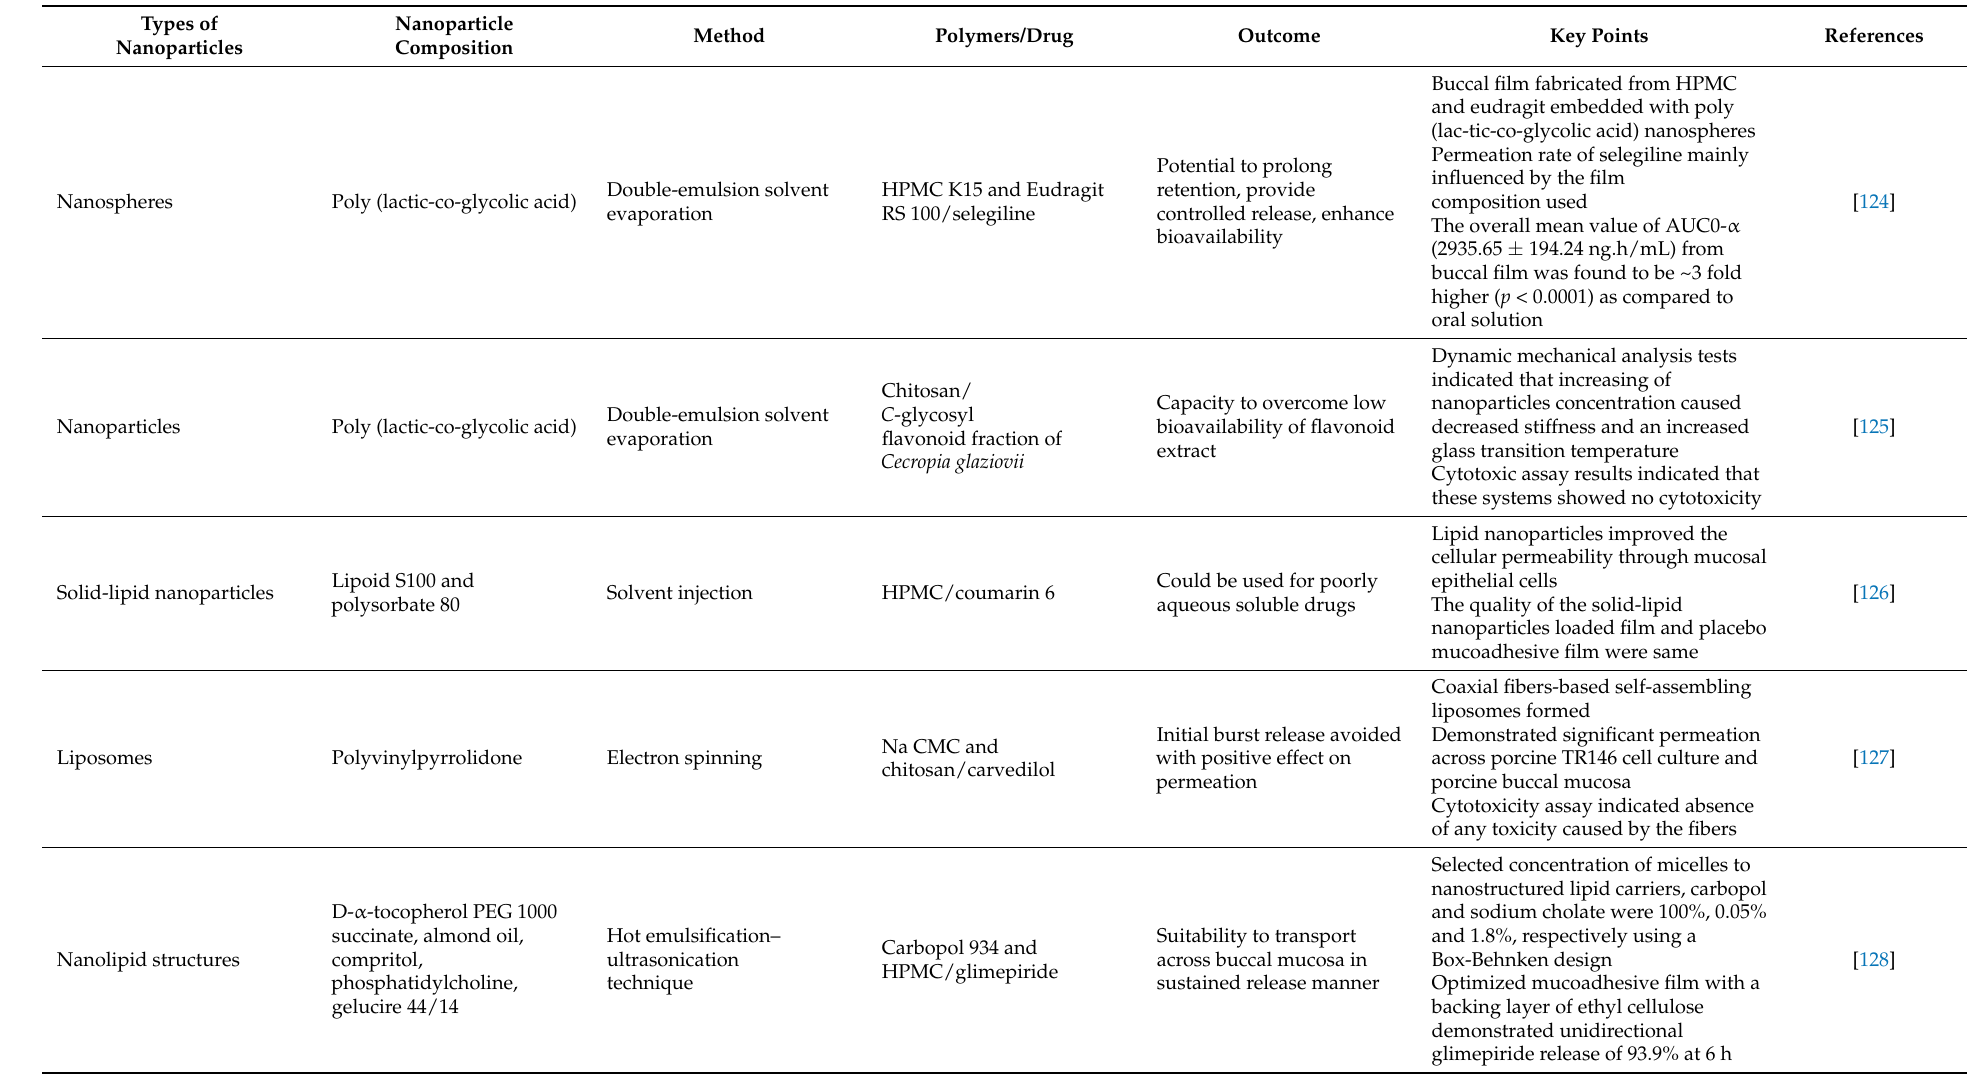
Table 4. Frequently used polymeric and lipid nanoparticles for buccal delivery and their